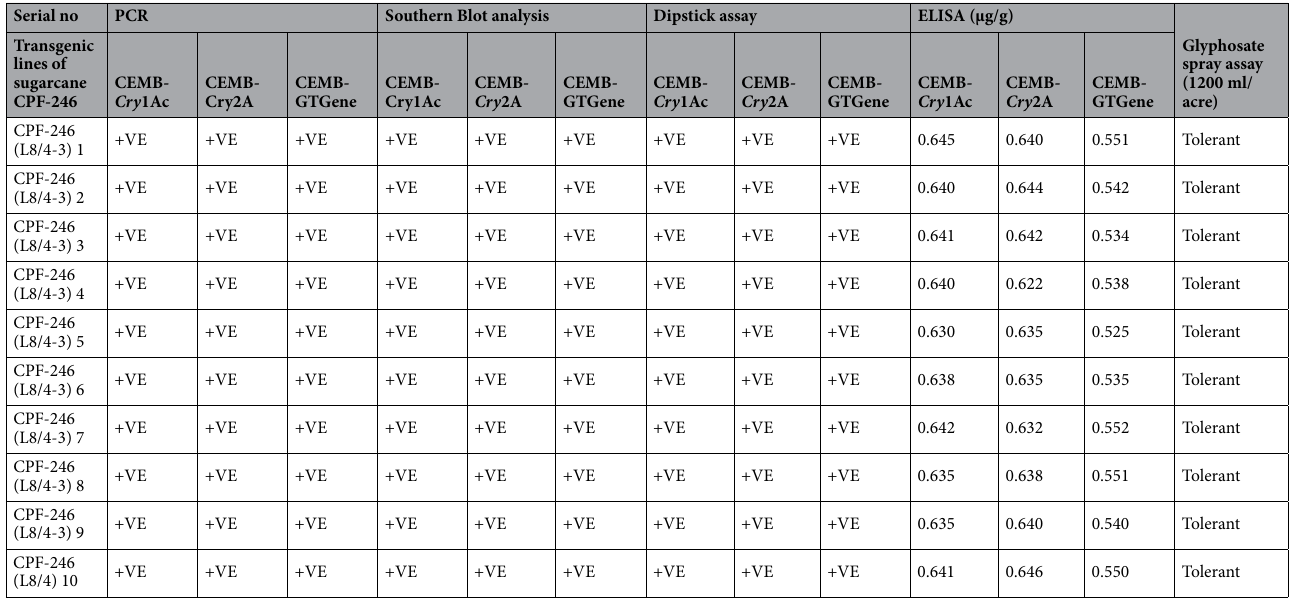
Table 8. Molecular analysis of CPF-246 (L8/4-3) transgenic sugarcane plants from V 2